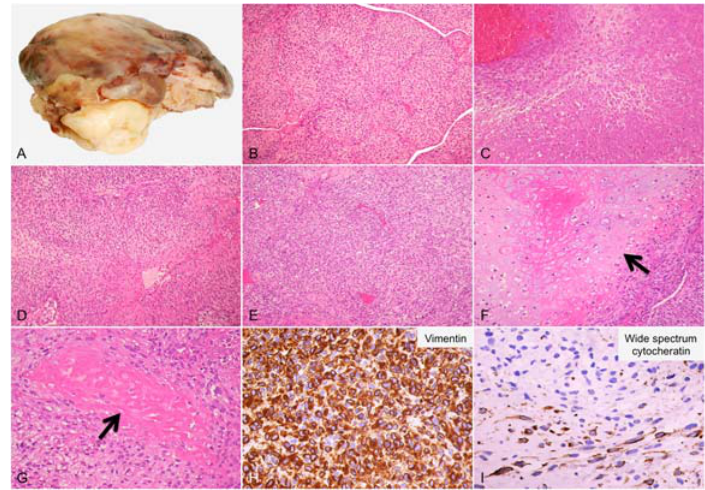
Figure 1. Histological findings representing the osteosarcoma sample. ( A ) Macroscopic aspect of the neoplastic mass formed by solid whitish ‐ gray tissue; ( B , C ) malignant neoplasia forming solid nests or intersecting bundles (100×) with areas of necrosis (200×), respectively; ( D – G ) proliferation con ‐ sisting of pleomorphic spindle (200×) or rounded cells (200×) with areas of chondroid (200×) and osteoid matrix (200×), respectively; ( H , I ) immunohistochemistry of neoplastic cells diffusely posi ‐ tive for vimentin (400×) and focally positive for wide ‐ spectrum cytokeratin (400×), respectively. ( B – G ): Hematoxylin–eosin staining.